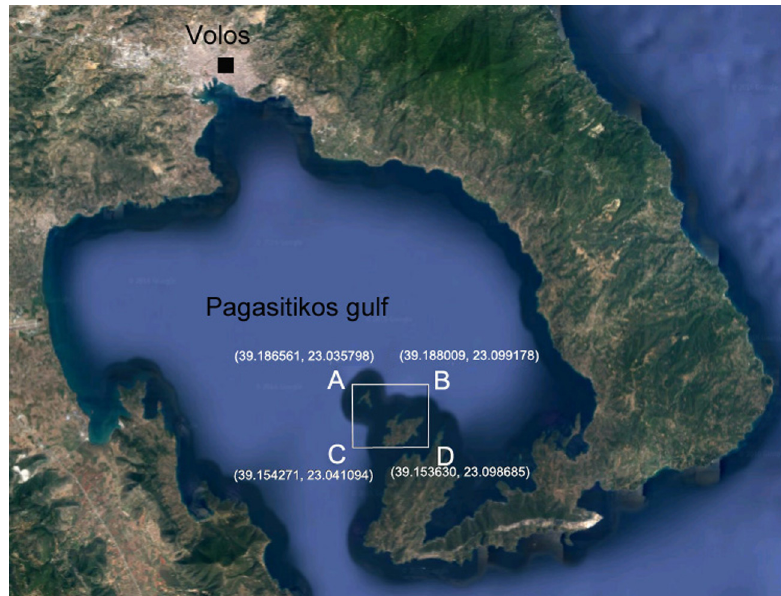
Fig. 1. Pagasitikos gulf. Sampling area was the rectangular